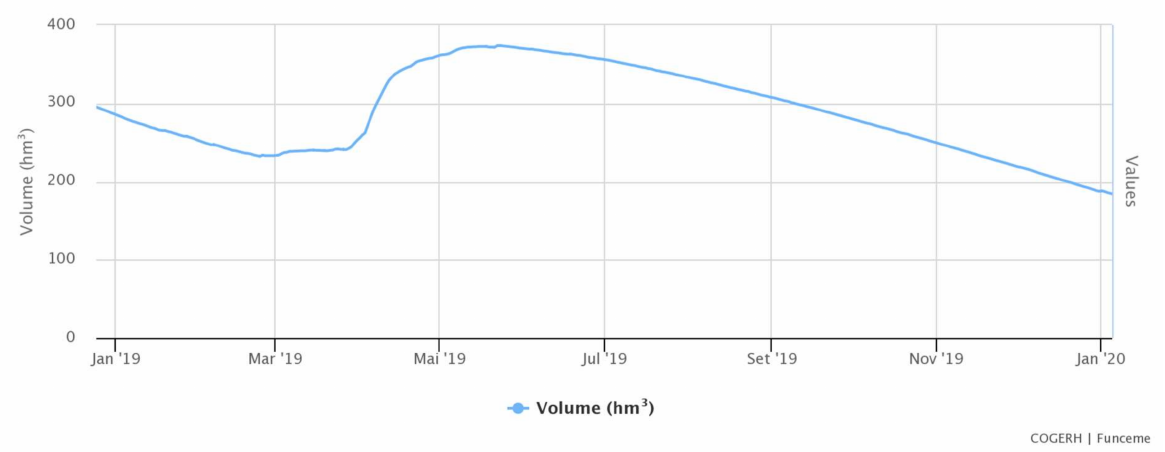
Figure 9. Variation in the daily water volume in the Castanh ã o reservoir during 2019. Release discharge: 7476 m 3 /s. Available by COGERH at the website http://www.hidro.ce.gov.br/hidro-ce- zend/acude/nivel-diario (accessed on 17 January